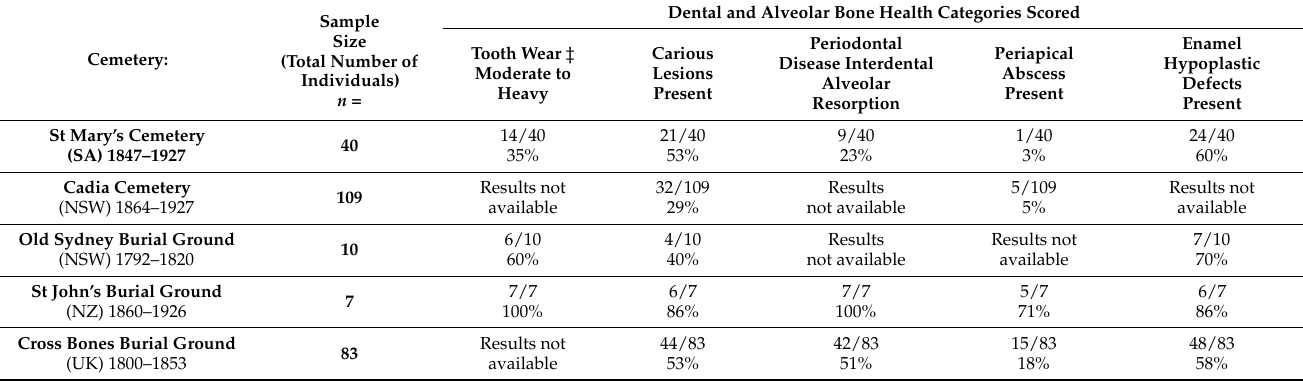
Table 10. Comparison of findings for the oral health categories investigated between the St Mary’s Cemetery sample and other 19th-century Australian, New Zealand, and British cemetery samples. The results presented in Table 8 are the number of individuals affected/number of individuals